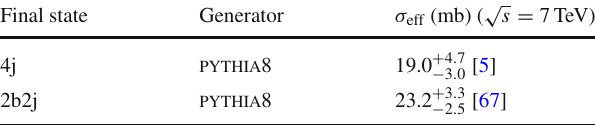
√ Table 4 Values of σ eff at s = 7TeV published by the CMS Collabo- ration for the four-jet final states, obtained by fitting predictions of the pythia 8 MC event generator to DPS-sensitive measured